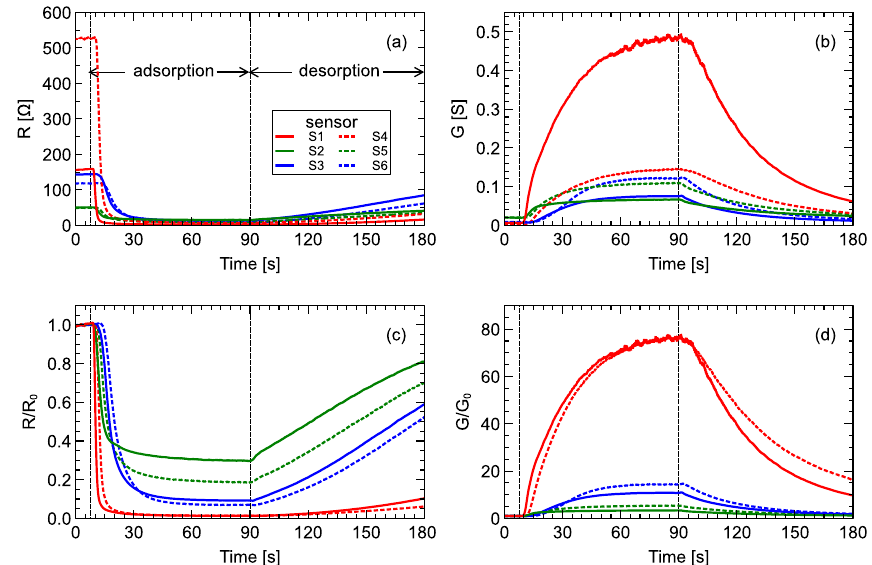
Figure 1. Typical sensor array response: ( a ) sensor resistance and ( b ) sensor conductance. Sensor responses standardized to the baseline measurements ( c ) R / R 0 and ( d ) G / G 0 . Vertical lines indicate various phases of the measurement process: baseline collection, gas adsorption, gas desorption. To not overload charts, assignment of all lines to the sensor numbers is indicated only in chart ( a ); line styles are consistent in all charts. Data measured by sensor pairs of the same type are plotted using the same color with different line styles. Measurements of average-quality wine (AQ_Wine02_B04_R01) were used in this figure.